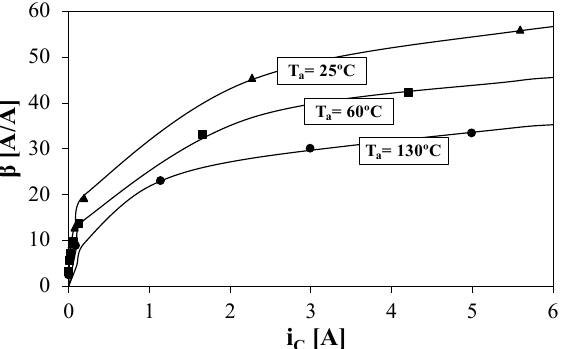
Figure 6. Isothermal dependence of the current gain factor at fixed values of an ambient temperature.